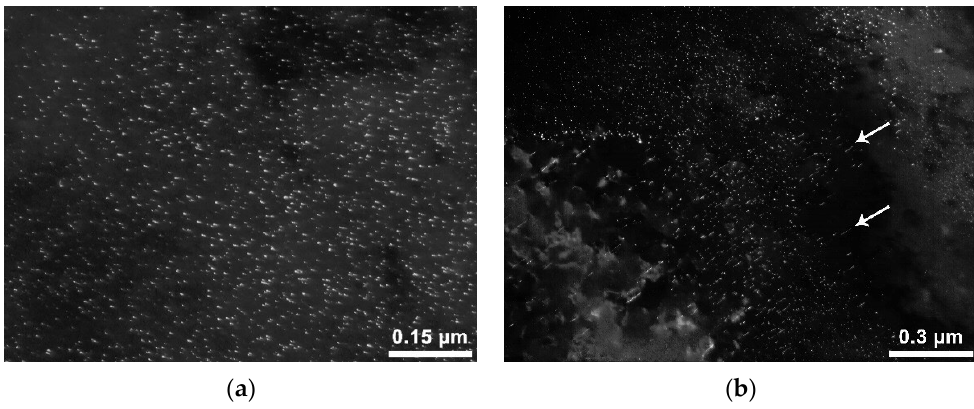
Figure 11. Dark-field image in reflections of nanosized carbonitrides (steel No 17): ( a ) Precipitates of approximately equiaxial shape with a size of no more than 2–3 nm; ( b ) Elongated precipitates (the arrows indicate the most characteristic elongated particles).